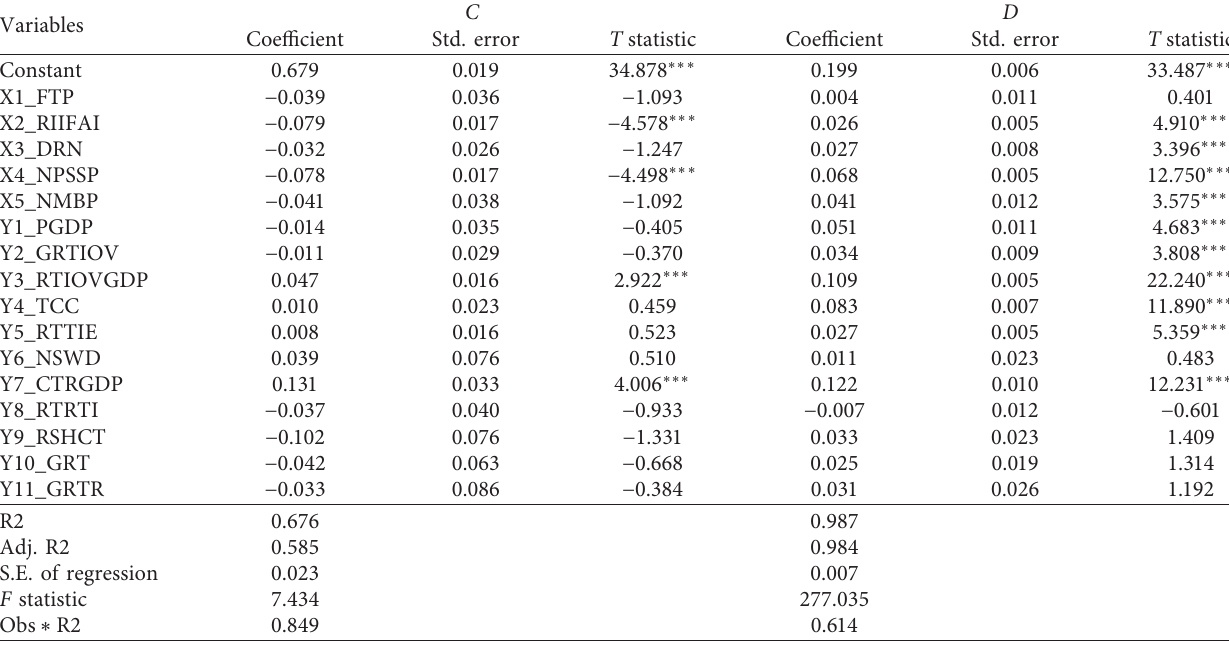
Table 5: Results of OLS method of the MLR